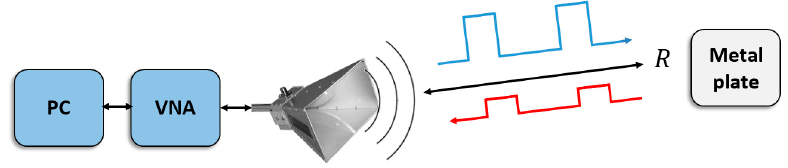
Figure 1. Diagram of the system.